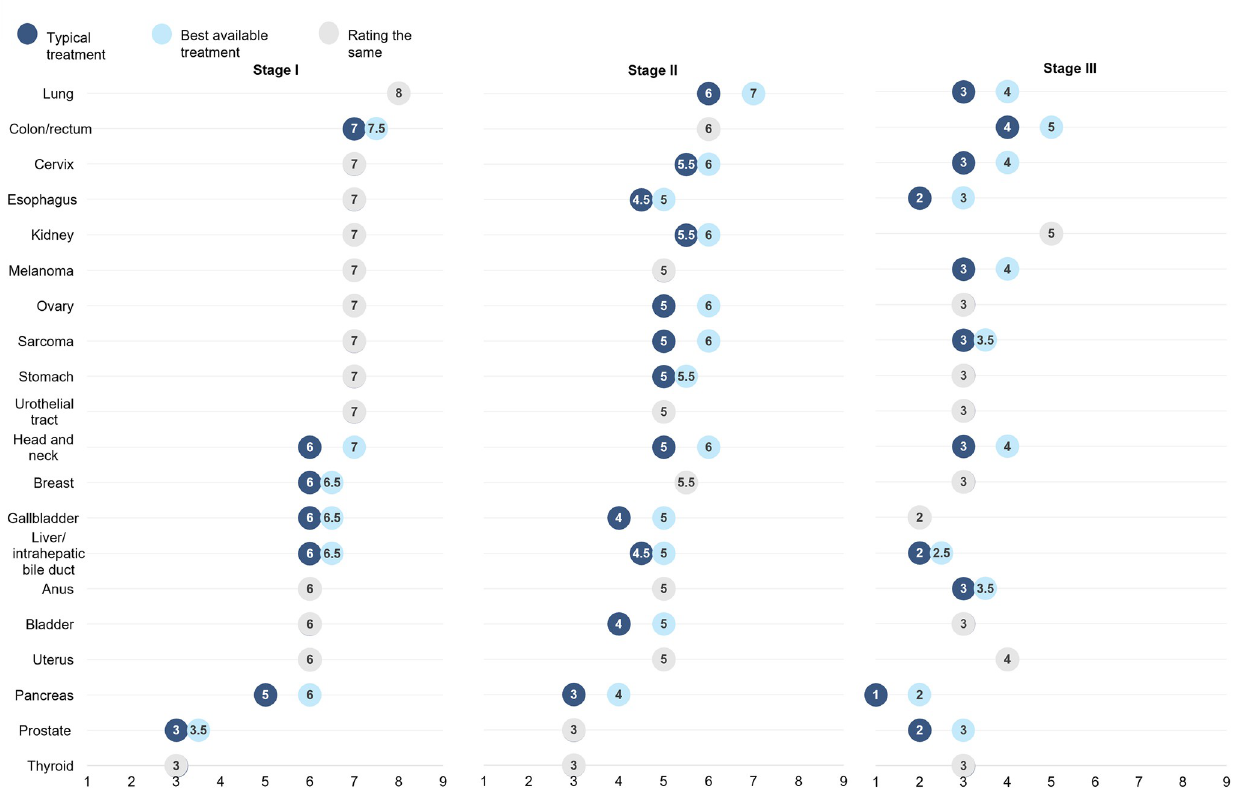
Fig 2. Estimated benefit from a hypothetical screening blood test with typical versus best-available treatment. This figure illustrates expert ratings on the estimated benefit from a hypothetical screening test, defined as the improvement in curability as a result of the test on a scale of 1 (not at all likely to increase) to 9 (increase a great deal), when considering typical versus best available treatment. Typical treatment was defined as the care provided to the population as a whole; best available treatment was defined as guideline-concordant care. Items in grey represent no difference in ratings for typical versus best available treatment. Items in blue represent a difference in ratings for typical versus best available treatment, with the dark blue representing typical treatment and light blue representing best available